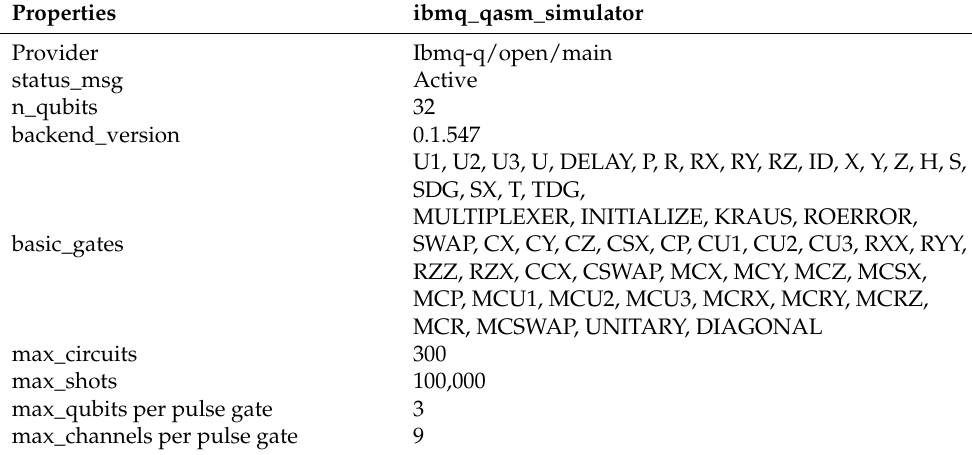
Table 1. Features of IBM